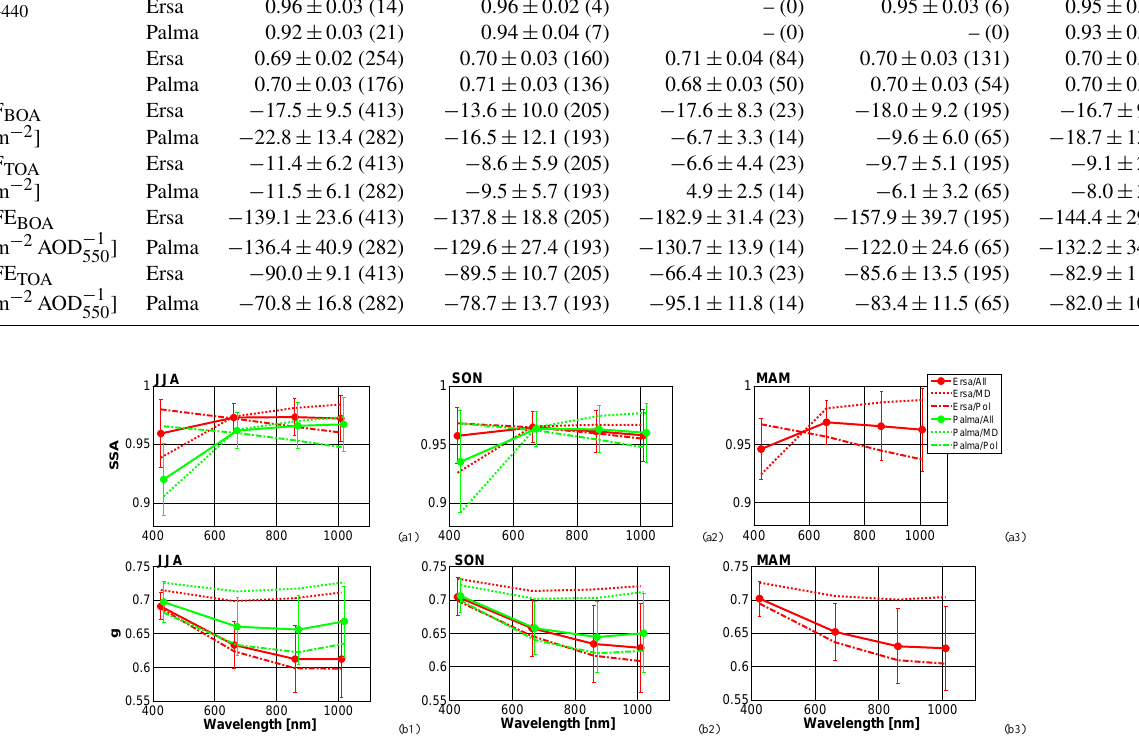
Figure 10. Seasonal variation of the spectra of (a) the single scattering albedo (SSA) and (b) the asymmetry factor ( g) during (1) summer, (2) autumn and (3) spring, derived from AERONET level 2.0 daily inversion products available for the period 2011–2015. The legend in plot (a3) applies for all plots (a) and (b) . SSA is retrieved with the following restrictions: 50<solar zenith angle<80 ◦ and an aerosol optical depth at 440nm (AOD 440 ) >0.4. The error bars represent the standard deviation. The seasonal mean is represented for the whole dataset (All) and separately for strong mineral dust (MD) and strong pollution (Pol) cases determined with the classification obtained from Fig. 8 (see first paragraph of Sect.